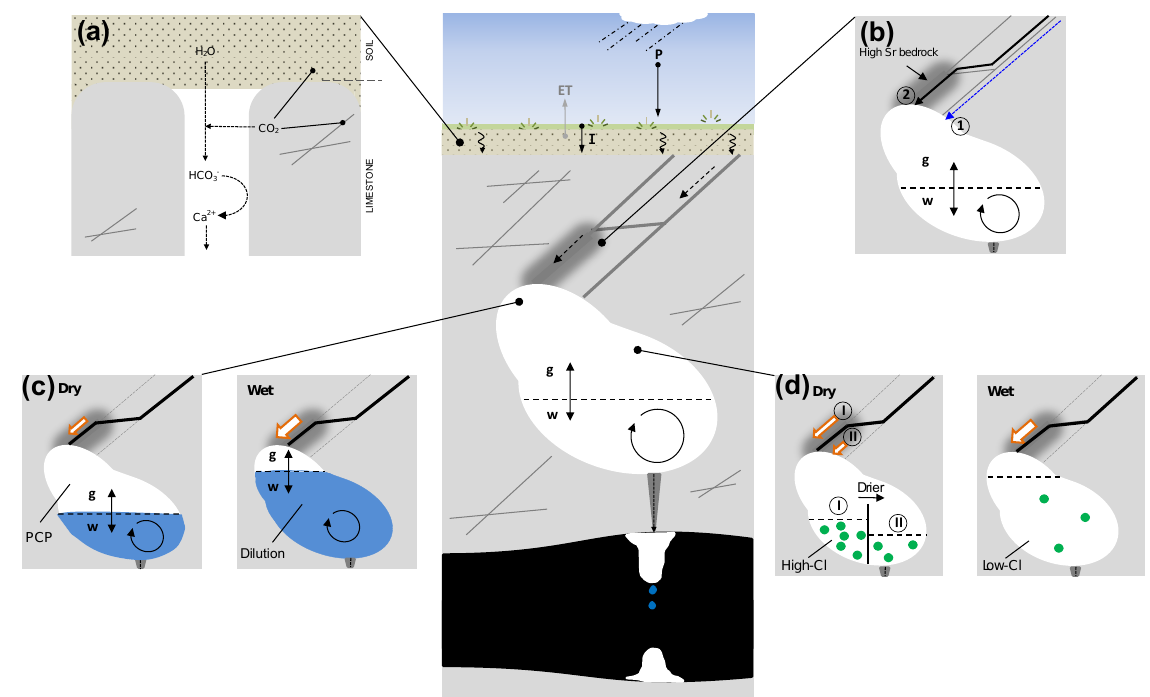
Figure 6. Conceptual model summarizing key process affecting drip-water hydrochemical variations at Harrie Wood Cave. Shown are precipitation ( P ), evapotranspiration (ET) and infiltration ( I ) infiltrations corresponding to when rainfall exceeds 13mm. Stalactites from drip sites HW1–3 are fed by fracture flow from a ventilated well-mixed pocket reservoir with a variable head within the epikarst. (a) Soil and unsaturated/vadose zone CO 2 drive CaCO 3 dissolution, increasing drip-water Ca. (b) The host bedrock varies geochemically and the dark grey shading along the fracture represents bedrock of higher Sr concentrations. A flow path change from 1 to 2 (October 2007) results in drip water being enriched in Sr. The size of flow arrows in (c) and (d) qualitatively correspond to recharge to the epikarst storage reservoir. (c) PCP within the store is enhanced during dry periods as the water level ( w ) is low, fairly constant and in contact with a greater ventilated gas phase ( g ). Dilution occurs during wet intervals due to greater inflow and PCP decreases as a reduced reservoir head space limits degassing ( w > g ). (d) During dry periods, the response to reduced inflow (I to II) is a decrease in Cl concentrations within the storage reservoir and therefore drip water. In wet periods, Cl is flushed from the soil–vadose zone and then diluted within the store, resulting in a sharp decline in drip-water